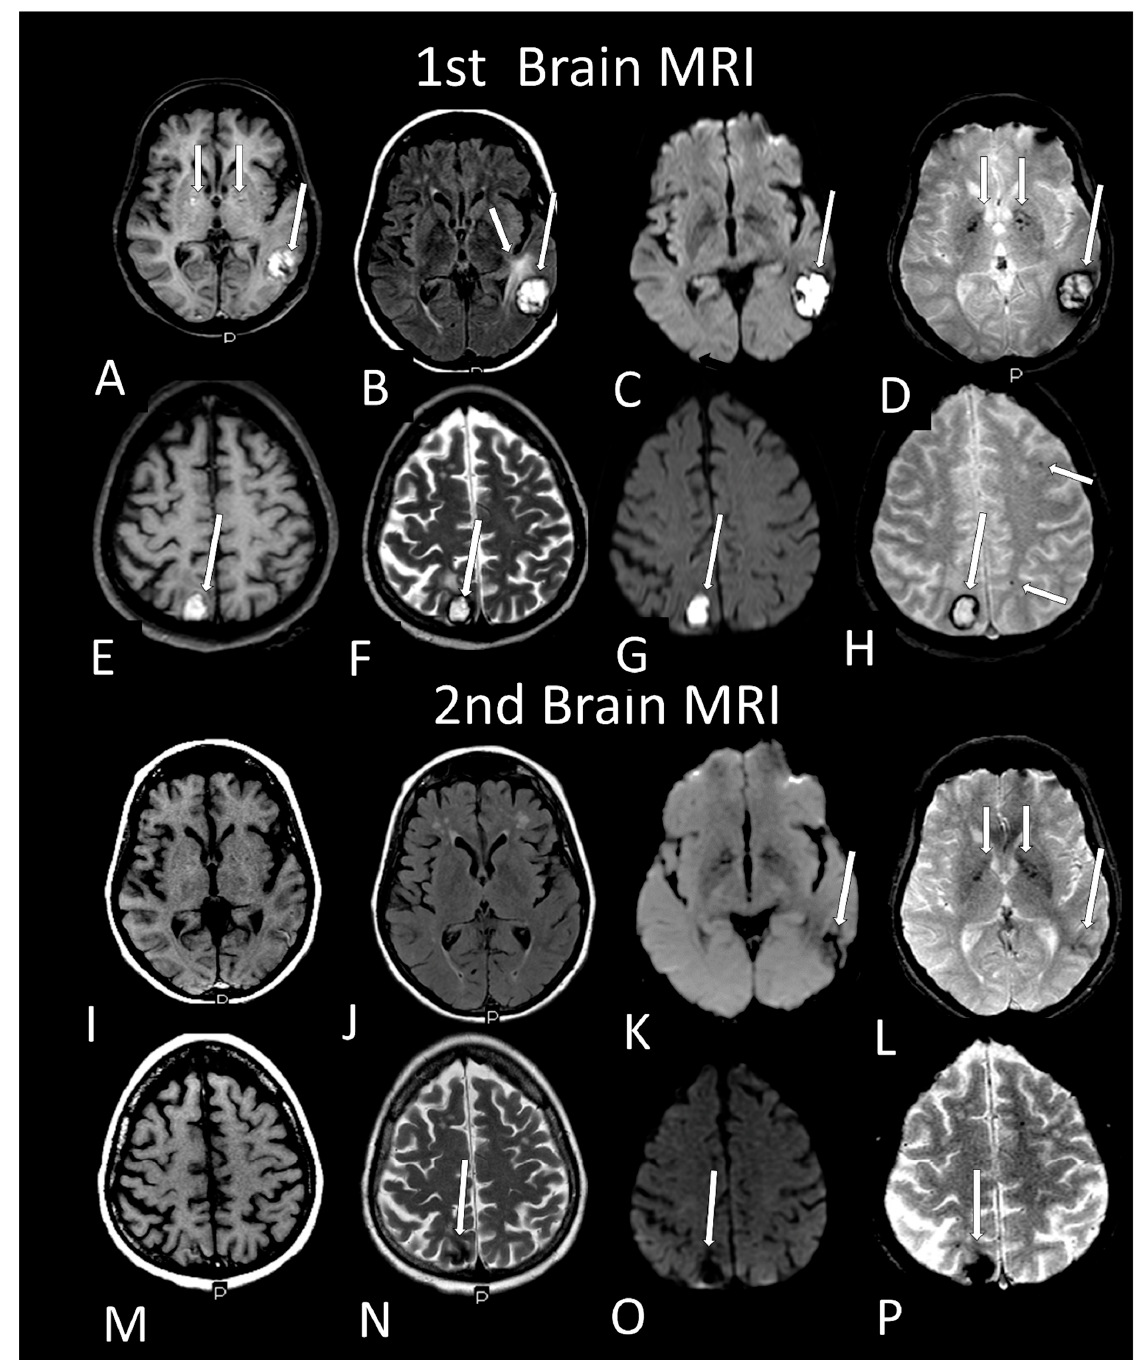
Figure 9. Case 27—On MRI, there is a subcortical hematoma located respectively in transition between left posterior temporal lobe and occipital lobe (long arrow A – D ) with hyperintense methemoglobin inside on T1WI ( A , long arrow), FLAIR ( B , long arrow), DWI ( C , long arrow) and T2* ( D , long arrow) and with hemosiderin in the periphery being hypointense ring. There is vasogenic edema near the left temporal hematoma being hyperintense on FLAIR ( B , short arrow). There is also microbleeding in pale globes ( A , D , short arrows). Another cortical hematoma in the right parietal lobe ( E – H , long arrow), with the same characteristics described above with methemoglobin inside and hemosiderin in the periphery. There are small dots of subcortical microbleeding in the left frontal and parietal lobes ( H , short arrows). Two months later there was regression on MRI ( I – P ) of both hematomas in size, but deposition of hemosiderin remained being hypointense on all sequences [T1, ( I and M ); FLAIR, ( J ); DWI, ( K , O , arrow); T2, ( N , arrow); and T2* ( L , P arrows)] and in the lentiform nuclei ( L , small